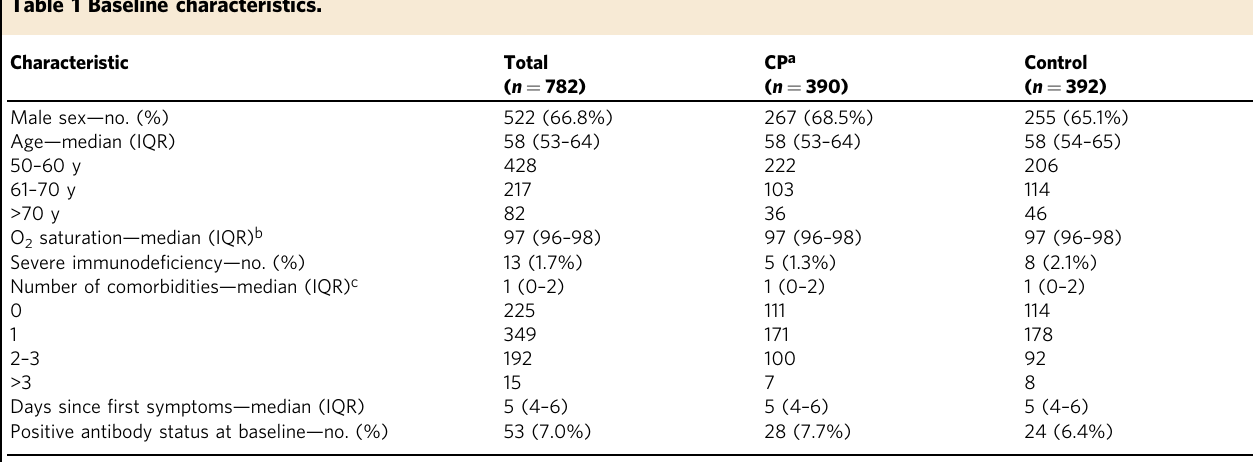
Table 1 Baseline